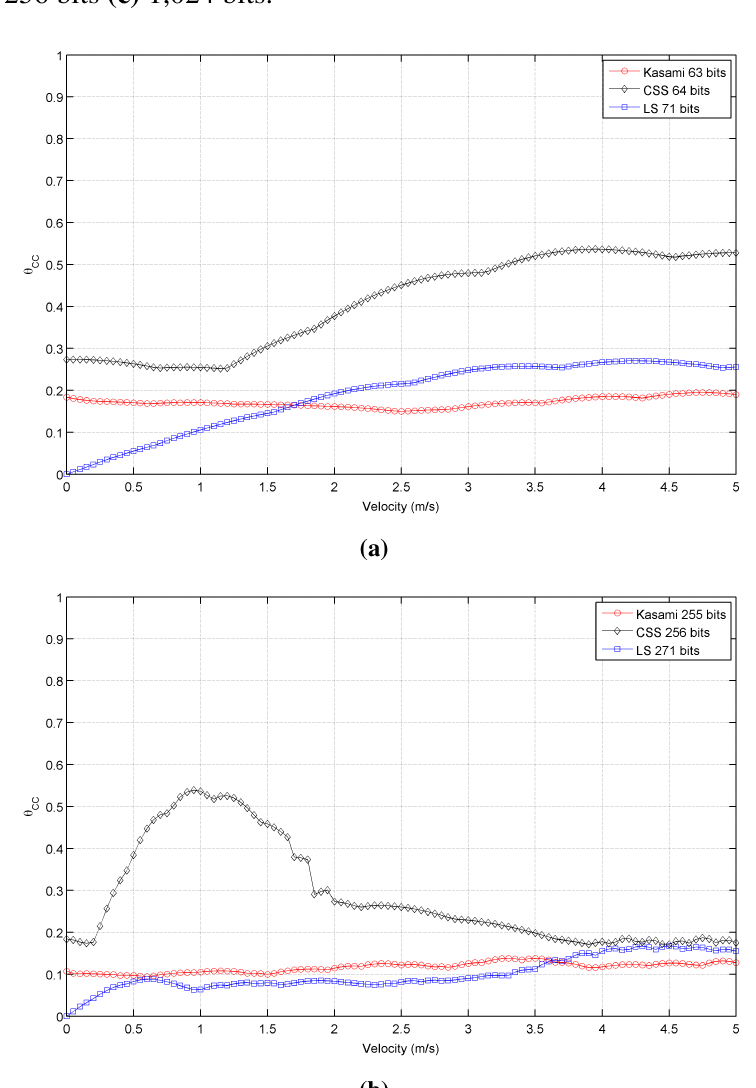
Figure 3. Simulated cross-correlation bound for the sequences with lengths close